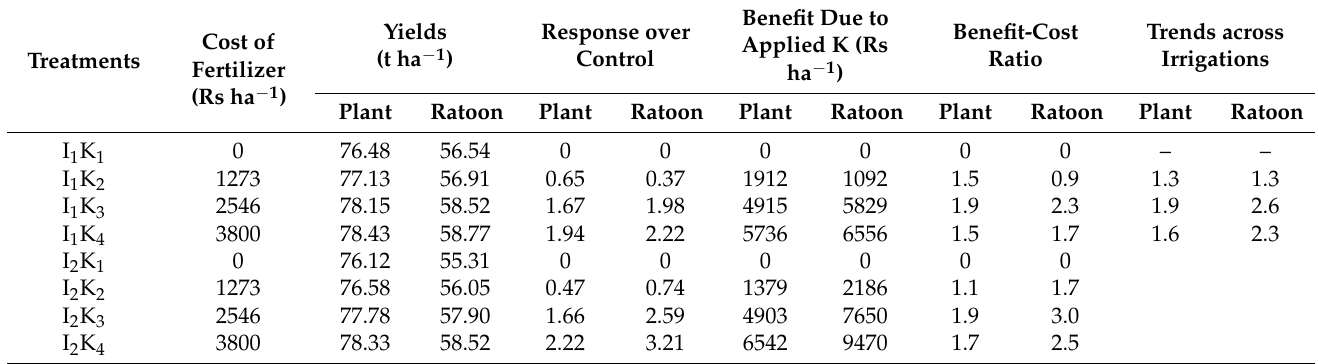
Table 12. Cane response and benefit to cost ratio as a function of irrigation and potash